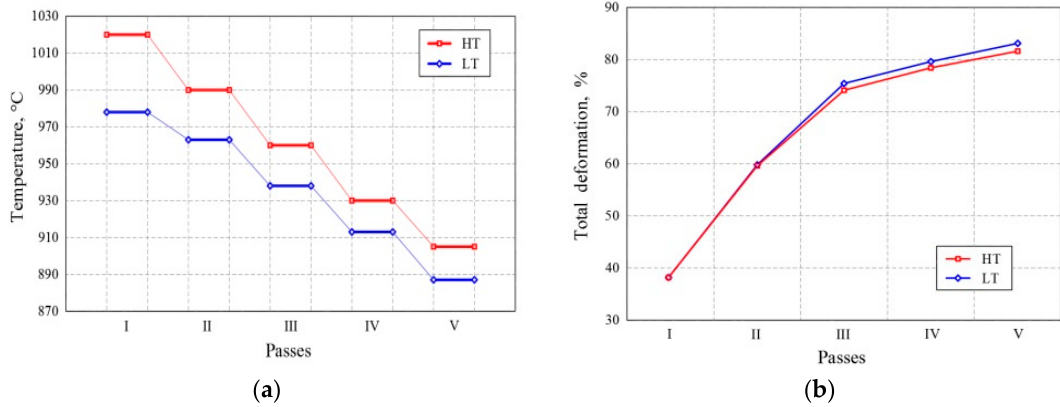
Figure 1. ( a ) Schematic of the final deformation (FD) and ( b ) the change in the degree of deformation.